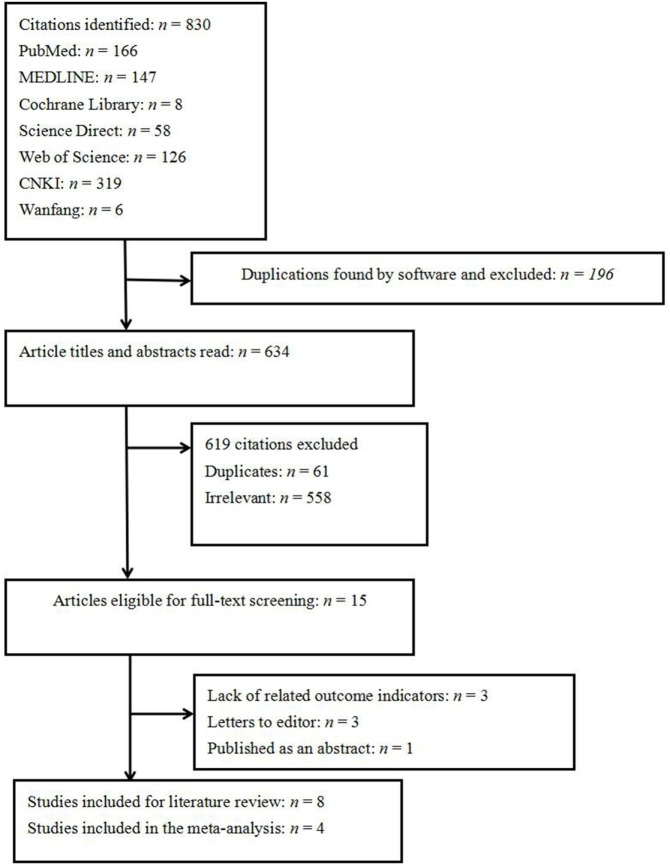
Systematic review flow diagram.